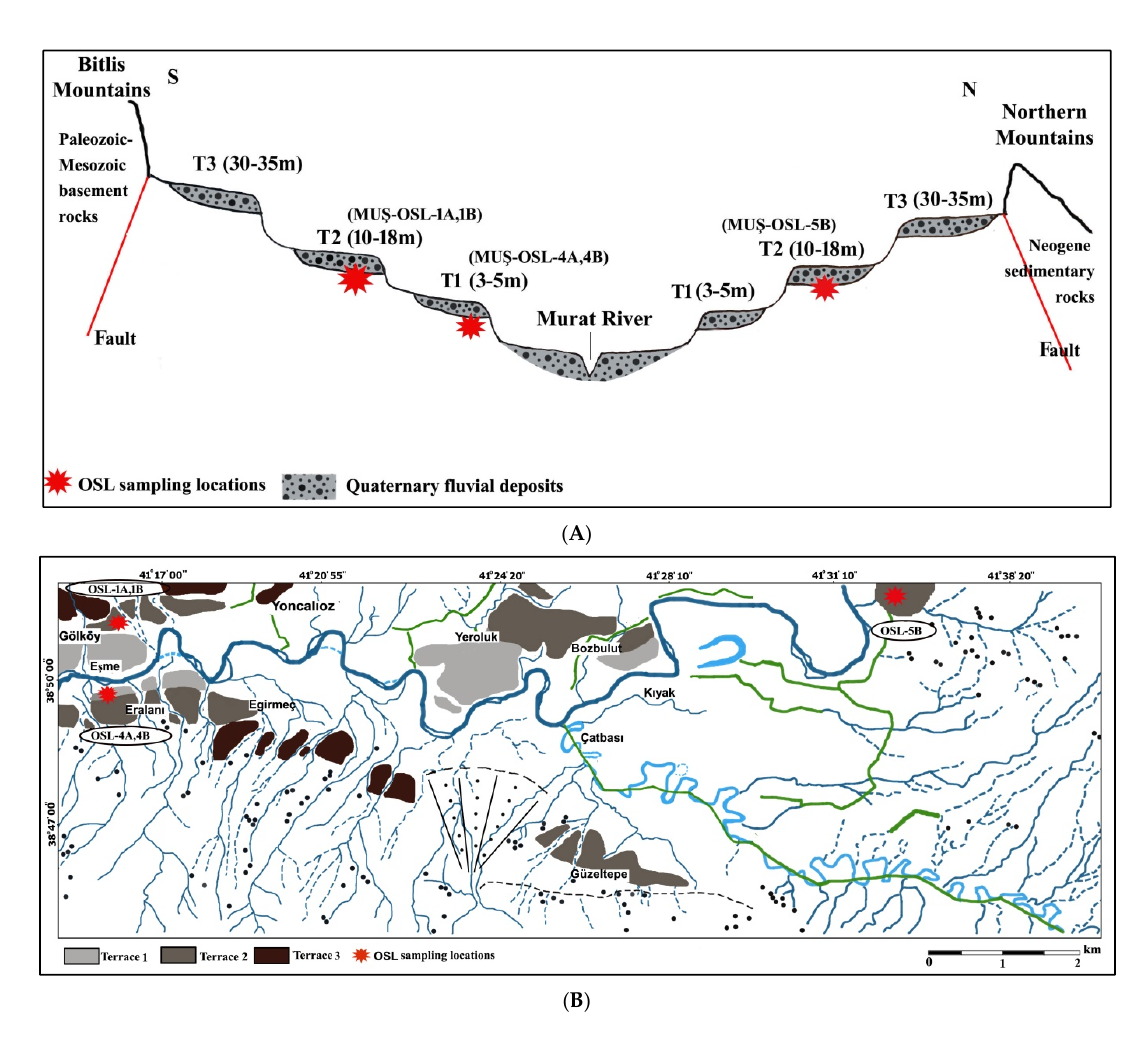
Figure 3. ( A ) The generalized section of the Murat River valley and the OSL sampling locations. The elevations are basement levels of the fluvial terraces. ( B ) Stream terrace dispersion (the altitudes of T1, T2 and T3 are 30–35 m, 10–18 m, 3–5 m) in the middle section of the Murat River.